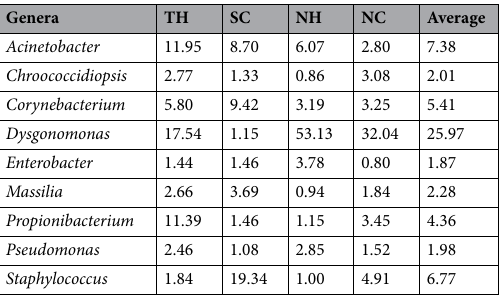
Comparison of five different healthcare-associated pathogens among four HCIs. The distribu- tion of putative human-associated microbes, especially HAPs, remains the main focus of infection control in hospitals. Hence, we compared the HAPs among four HCIs. Table 4 shows the results of a Student’s t-test on the abundance of bacterial taxa in four HCIs. Comparing five different HAPs among different HCIs, (1) the abun- dance of Acinetobacter was significantly higher in TH compared to NH ( p = 0.0307) and NH ( p = 0.0348); (2)